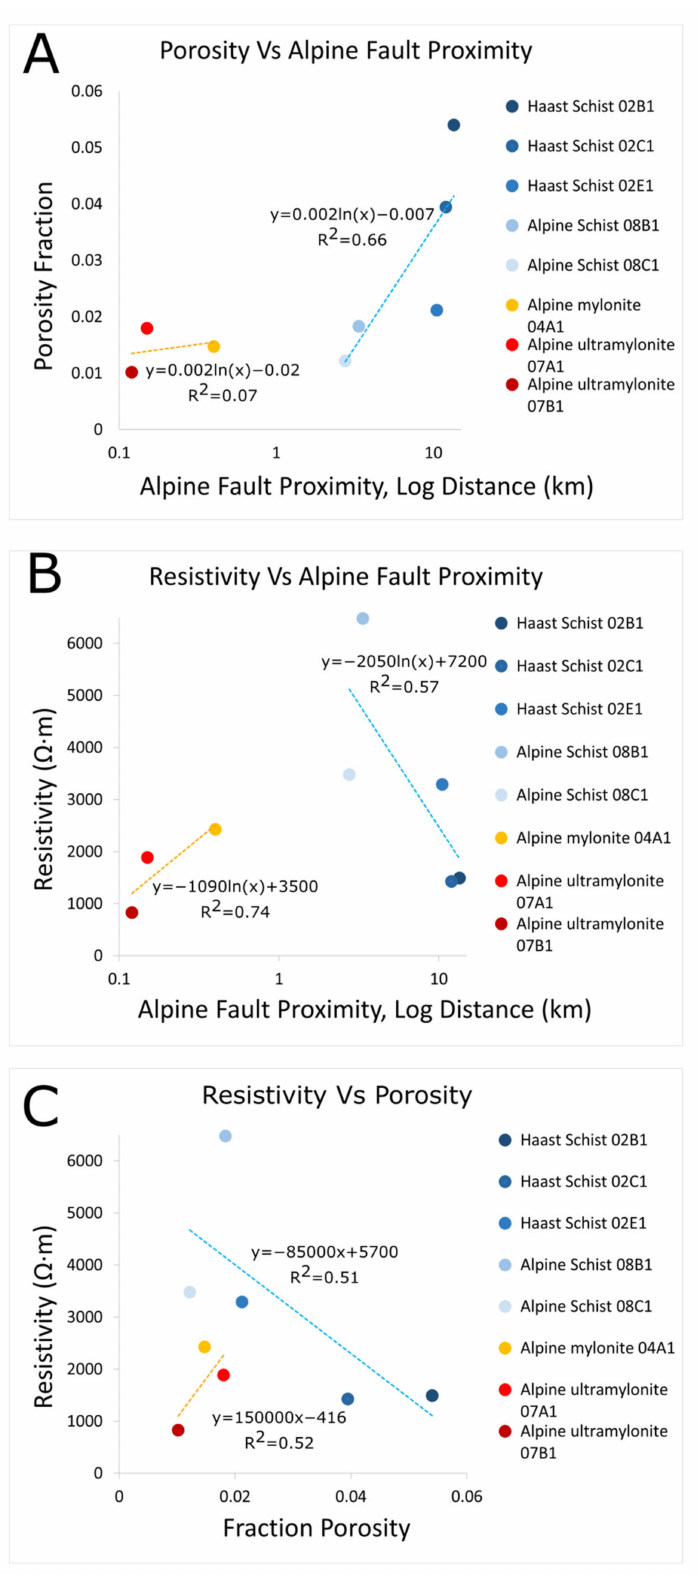
Figure 6. Resistivities measured on samples under increasing effective confining pressure. ( A ). Plot of sample porosities versus Alpine Fault Proximity. ( B ). Plot of sample resistivity versus Alpine Fault proximity. These measurements were made at 20 Hz during the Second Run at 100 MPa effective confining pressure (20 MPa pore fluid pressure). ( C ). Plot of sample resistivity versus sample porosity